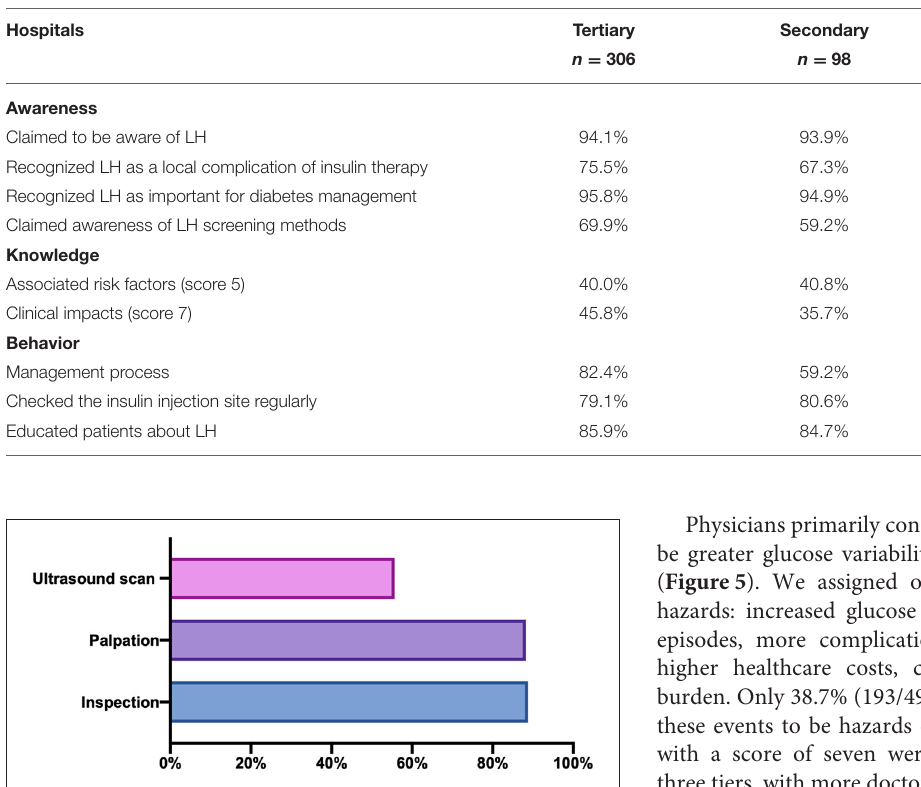
TABLE 1 | Insights into LH awareness according to the different hierarchical medical systems.